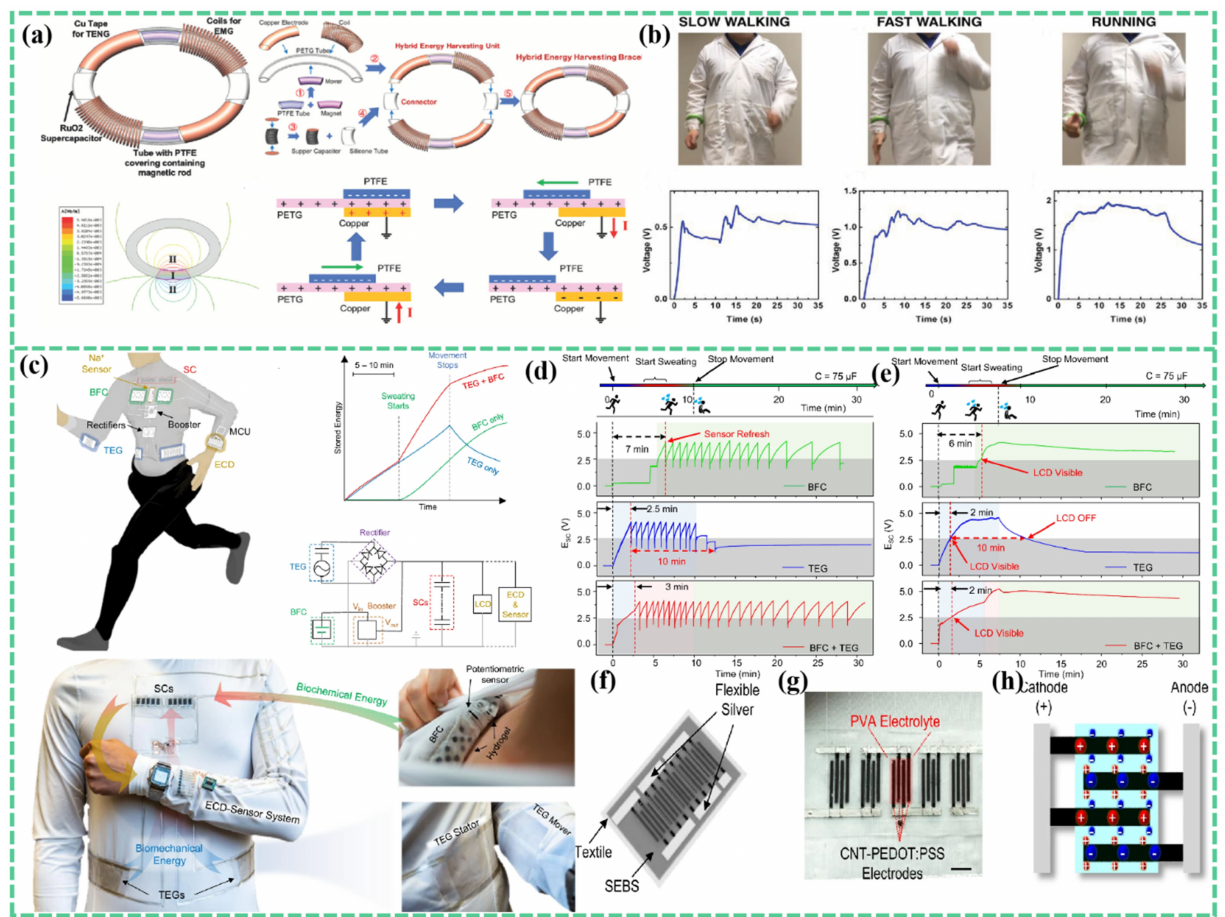
Figure 12. ( a , b ) A hybrid energy harvesting bracelet combines dual electromagnetic and TENG to harvest wrist movement. ( a ) The fabrication process and working mechanism of the hybrid energy harvesting bracelet. ( b ) Photograph and voltage of SCs measured under slow walking, fast walking, and running actuations. Reproduced with permission [111]. Copyright 2019, Wiley-VCH. ( c – h ) Harvesting of biochemical and biomechanical energy by sweat-based BFC and TENG. ( c ) Design and concept of the multi-modular energy microgrid system. ( d – e ) V-t curves under different operating modes. ( f ) Schematic image of the textile-based SC energy storage module. ( g ) The photo image of the printed SC module. ( h ) Charge storage mechanism of hybrid SC cells. Reproduced with permission [112]. Copyright 2018,